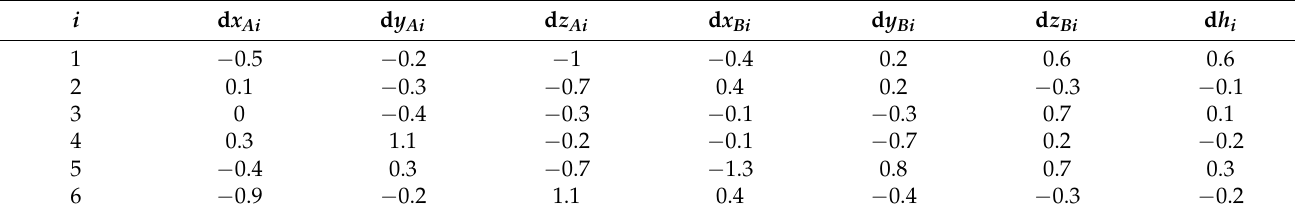
Table 6. Preset values of kinematic parameter errors (unit: mm).